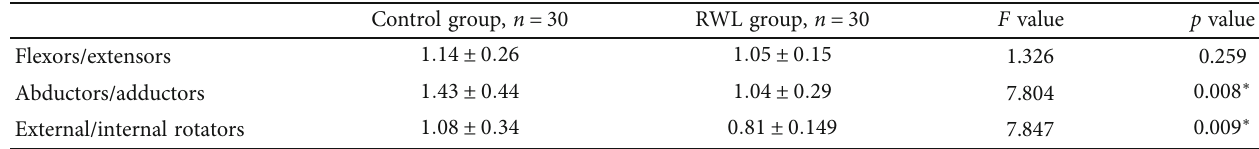
Table 3: Data analysis of shoulder muscles agonist/antagonist ratios at 120 °